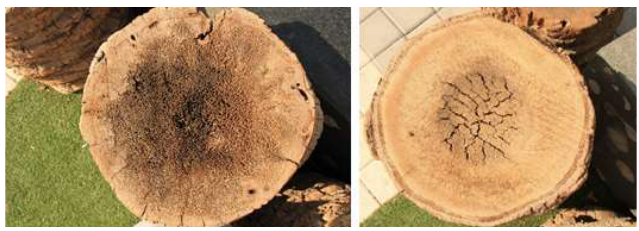
Figure 2: Date palm tree‘s trunk structure: left almost soft, and right when dried (photos by